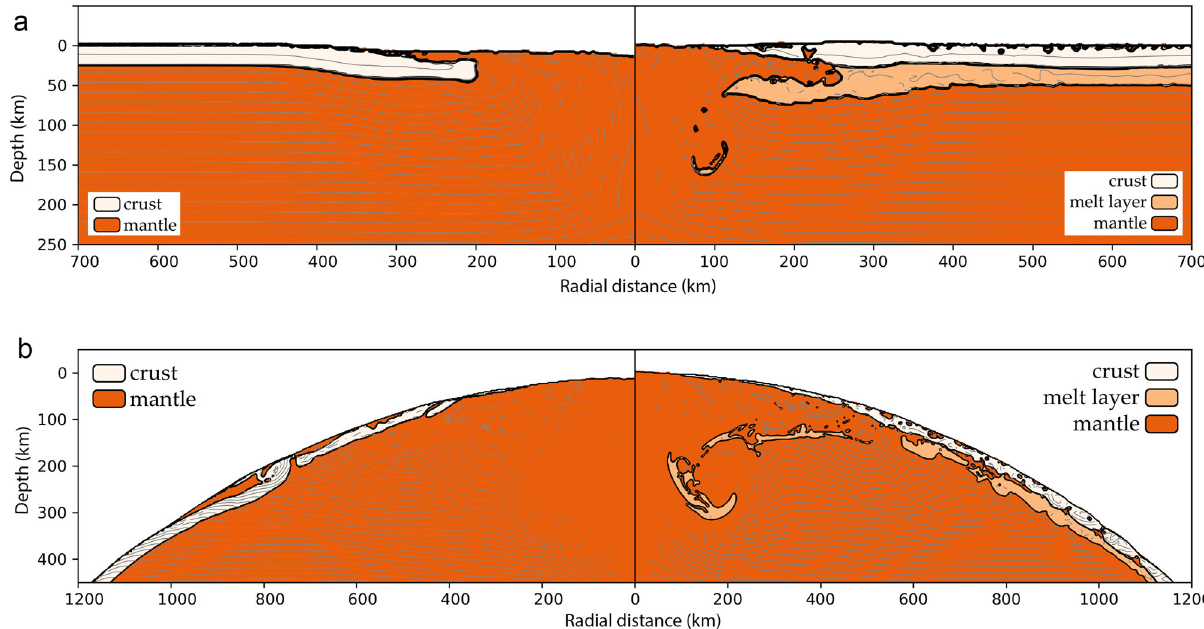
Fig. 2 Numerical iSALE-2D simulations of impact-basin formation. a 60-km diameter projectile striking the Moon at 17 km/s, forming an Orientale-sized basin, and b 120-km diameter projectile striking the Moon at 17 km/s, forming a South Pole-Aitken-sized basin. The panels on the right show results when a 25-km thick melt layer is present between a 25-km thick crust and mantle, whereas the left panels show results without a melt layer. Simulation results are shown ~3 h after impact. Results are similar for a range of impact speeds, crustal thicknesses and melt-layer thicknesses. Beige colour denotes the crust, light orange is the melt layer and dark orange is the underlying solid